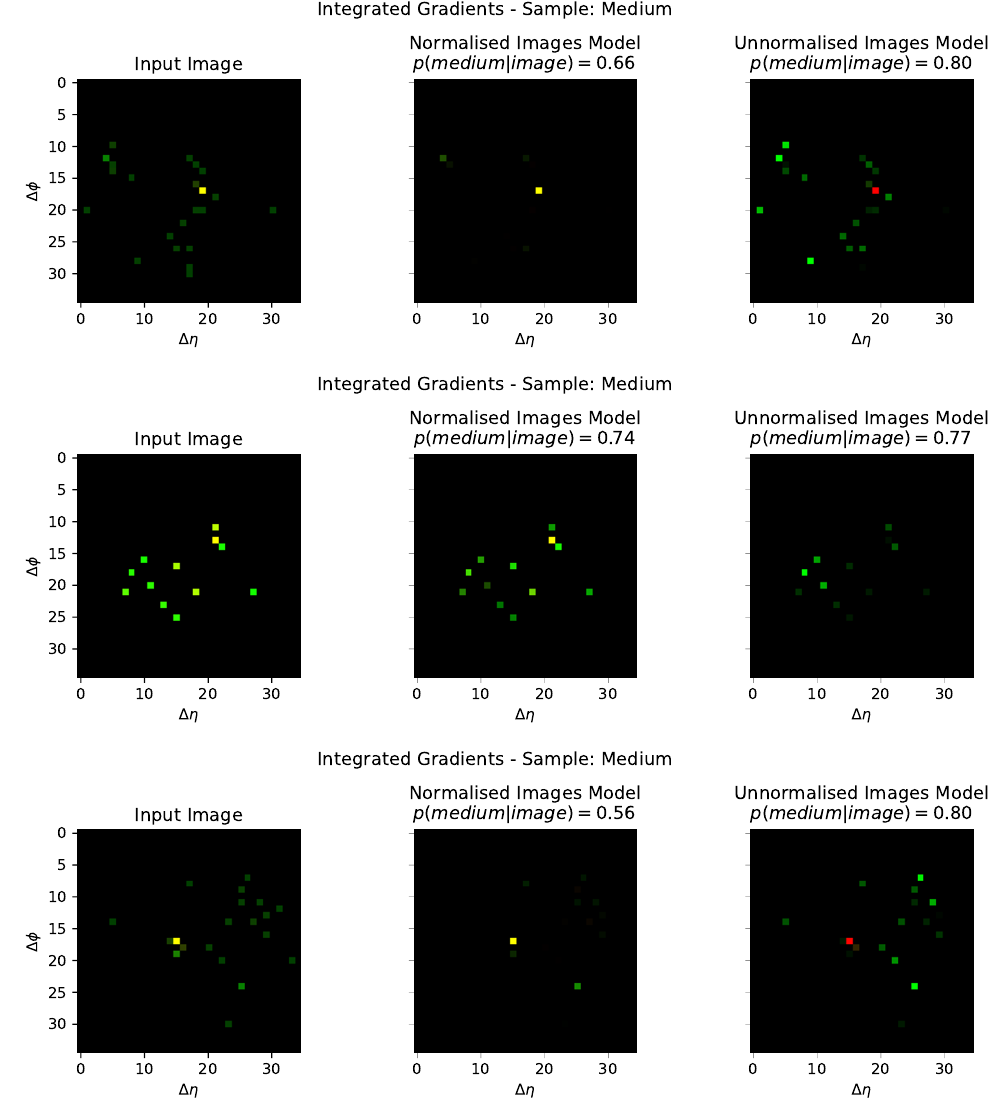
Figure 20 . Integrated gradients for some correctly classified medium sample